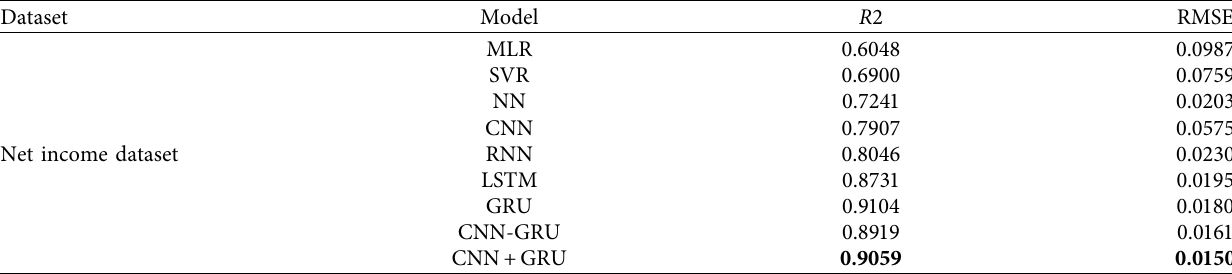
Table 1: Experimental results of forecasting net profit.